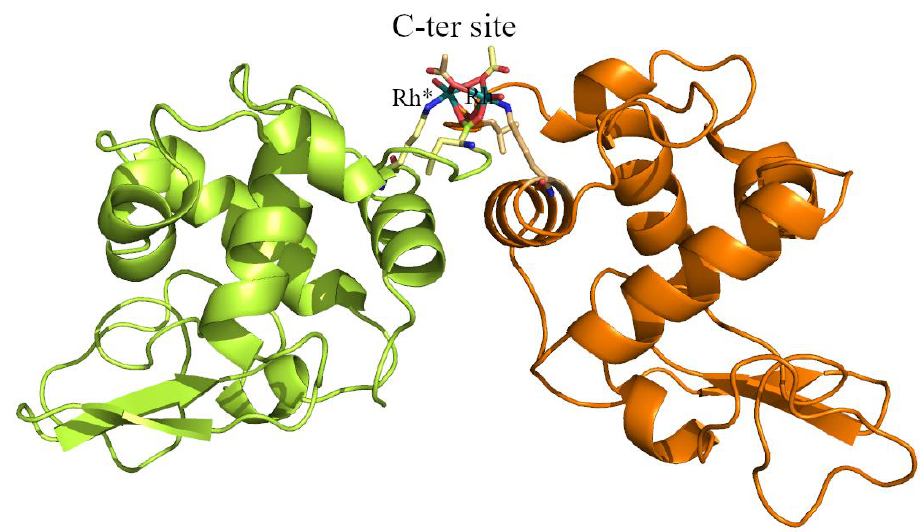
Figure 5. Structure of the cross-linked hen egg white lysozyme (HEWL) dimer formed in the Rh/HEWL crystals obtained when the protein is treated with [Rh 2 (μ-O 2 CCH 3 ) 4 ].* Referes to the symmetry related molecule.